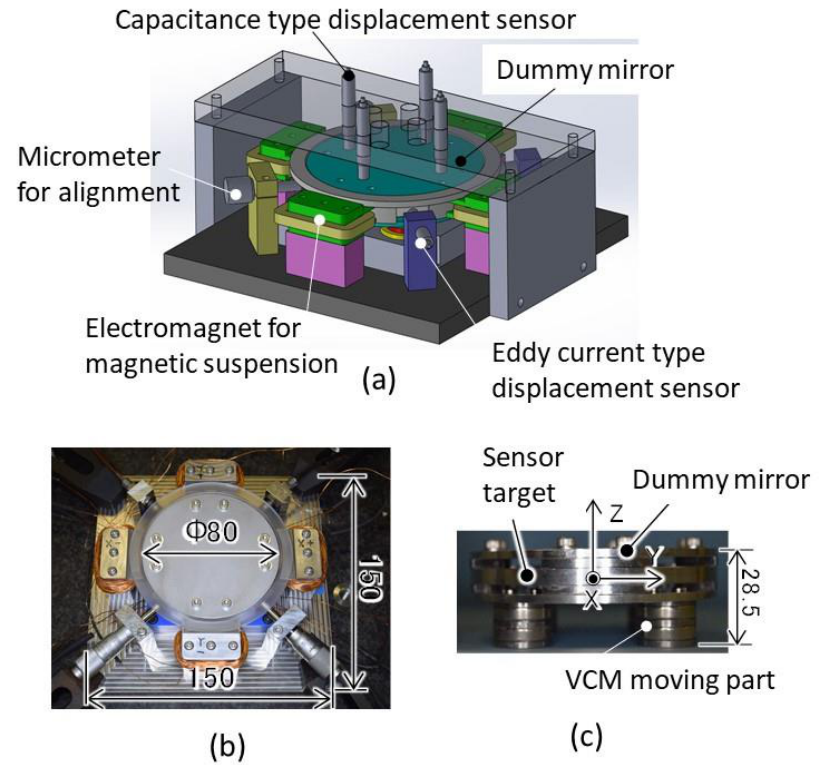
Figure 8. The test rig using the magnetic suspension mechanism: ( a ) The configuration of the test rig; ( b ) top view of the test rig without the displacement sensors; ( c ) side view of the suspended part including the dummy mirror.